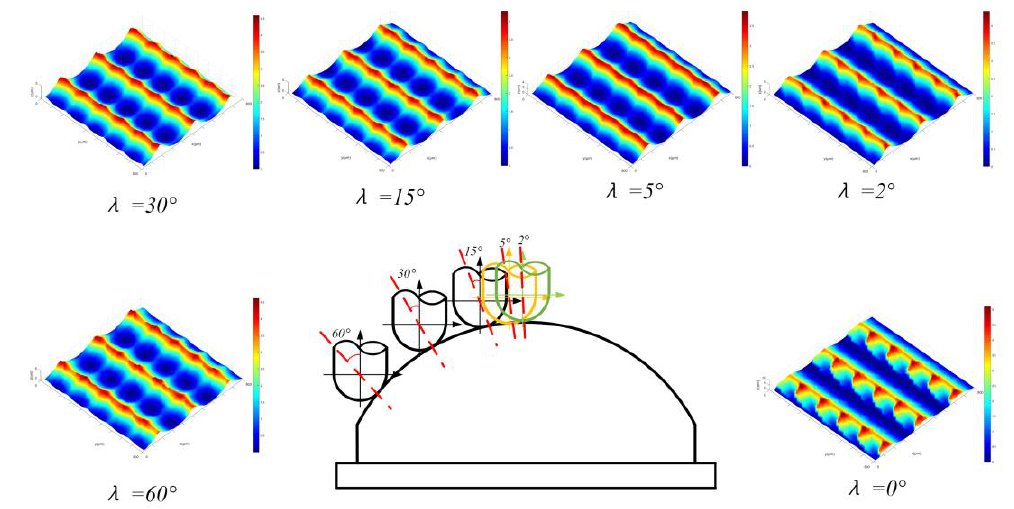
Figure 12. Surface topography simulation results at di ff erent positions of the surface.